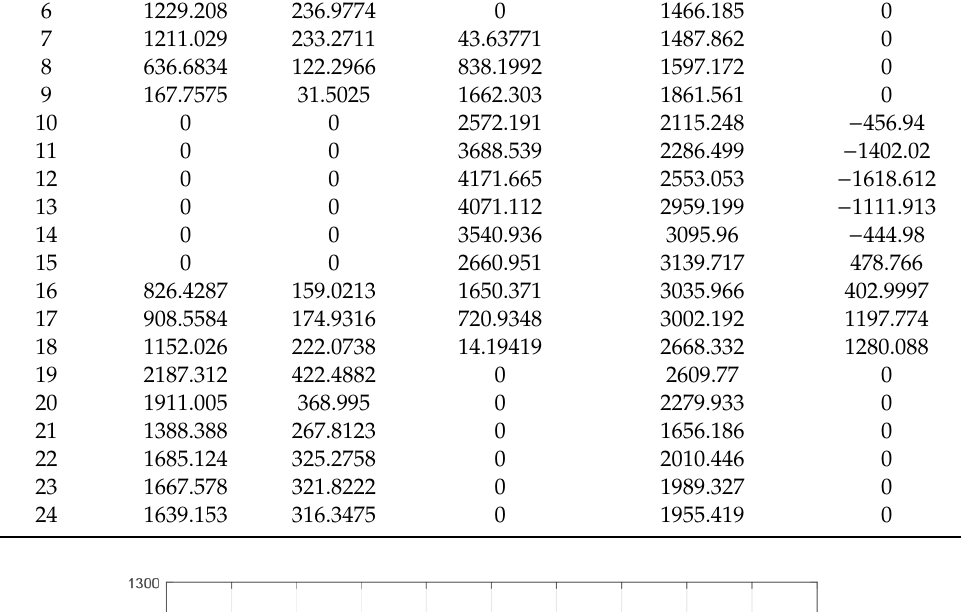
Table 7. Economic dispatch solution using the particle swarm optimization (PSO) Technique.